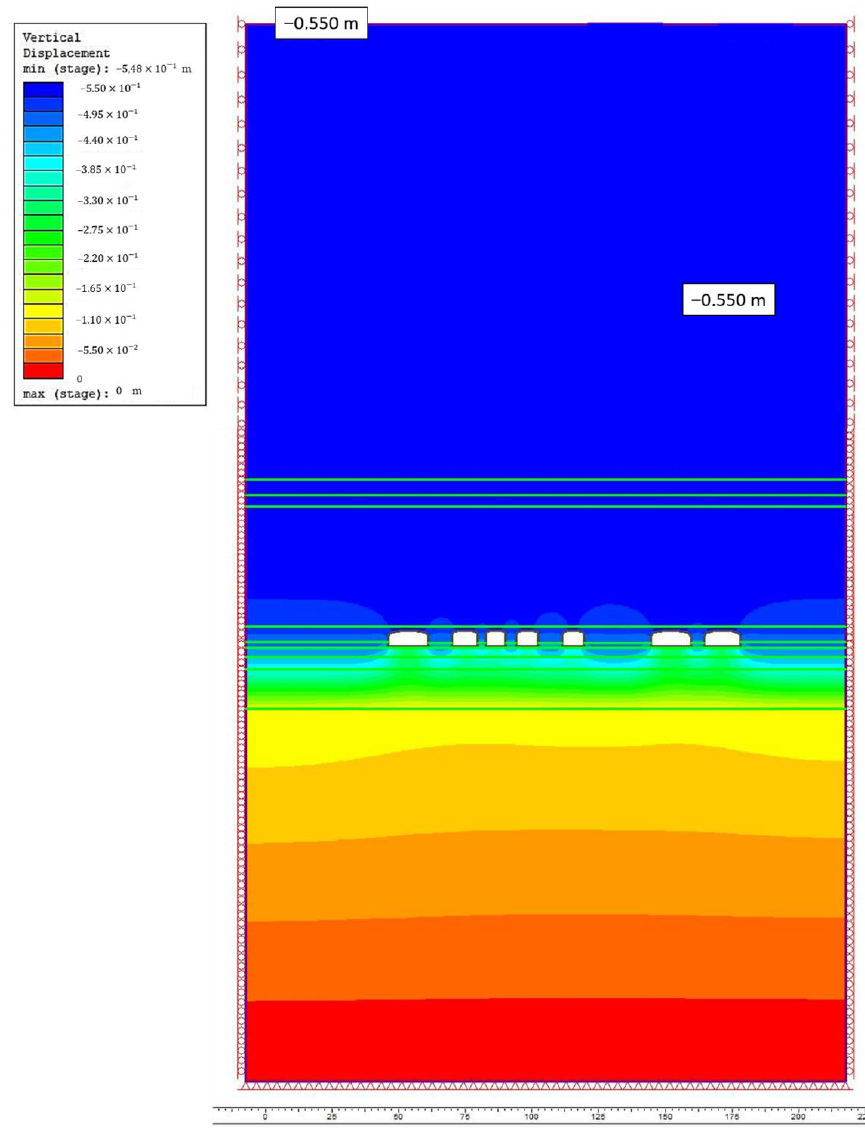
Figure 10. Example of the FEM post-processing stage achieved using RS2. Table 2 shows the values obtained for the twelve mining zones tested, the average subsidence profile with a 90% level of confidence. It can be seen that in most of the stages, the values obtained with the RS2 model are within the level of confidence (Figure 11). In the first stage, the vertical displacement obtained by the FEM model ranges between − 14.2 and − 15.2 cm, being slightly out of the interval of − 8.7 and − 9.7 cm defined by the level of confidence of the actual values. This may be due to the values used as original material properties from laboratory tests could have some variation from their real in situ charac- teristics. However, the variation is still quite small and corrected over time with the sub- sidence evolution model. The main limitation is detected in the final stage, where subsid- ence stabilization should be modelled. However, achieving this trend requires recovering the initial properties in the last stage, which leads to an inconsistency with Young ’ s mod- ulus reduction technique. Another disadvantage of the software used is the need to sim- plify the model design. Therefore, if much detail is required, this fact can represent a